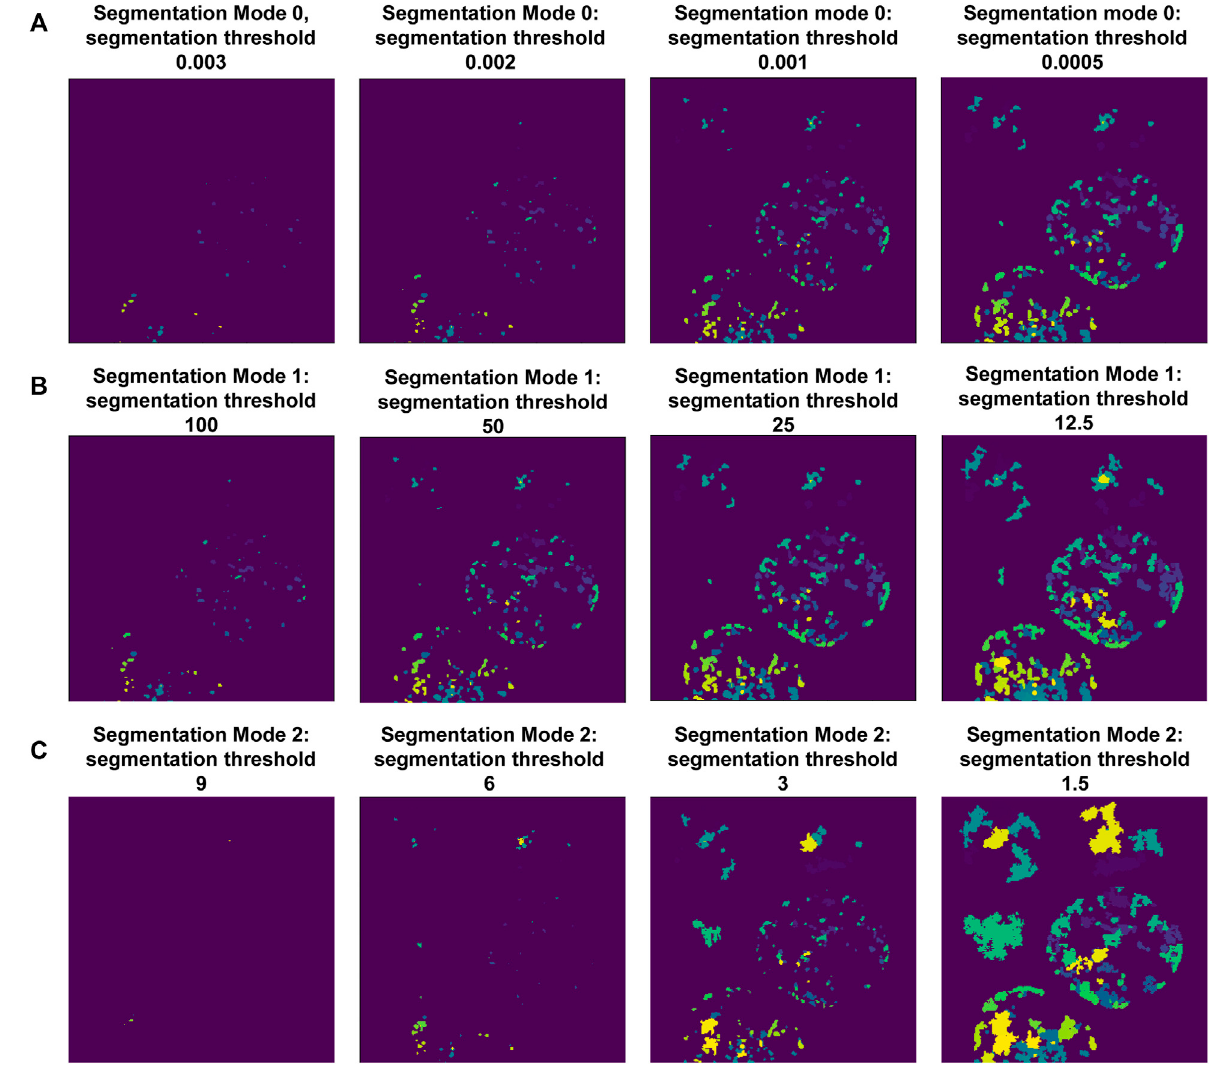
FIGURE 3 | Setting-up puncta segmentation. Puncta Segmentation can be done in three ways, shown using puncta centers identi fi ed in Figure 2C , background threshold=3. (A) Mode0segmentspunctabasedontheLoG fi lteredimage,usinga fi xedthresholdvalue. (B) Mode1segmentspunctabasedontheLoG fi lteredimage using a threshold value relative to the ROI background (LoG) intensity. (C) Mode 2 segments puncta based on raw intensity values using a threshold value relative to the ROI background